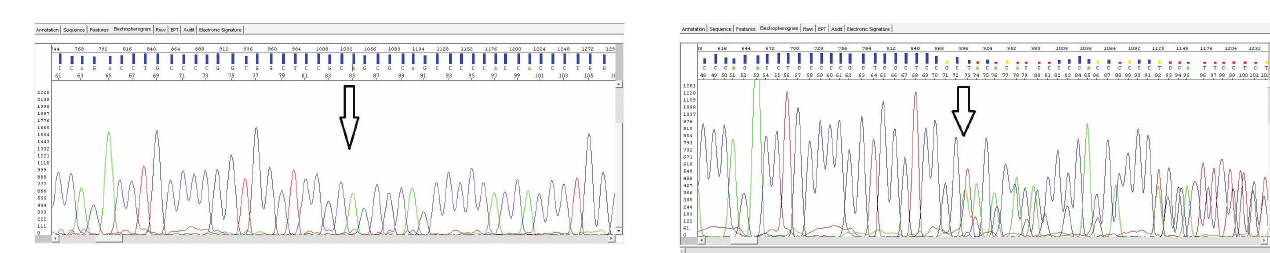
Figure 6: Paternal heterozygous del TACACCC